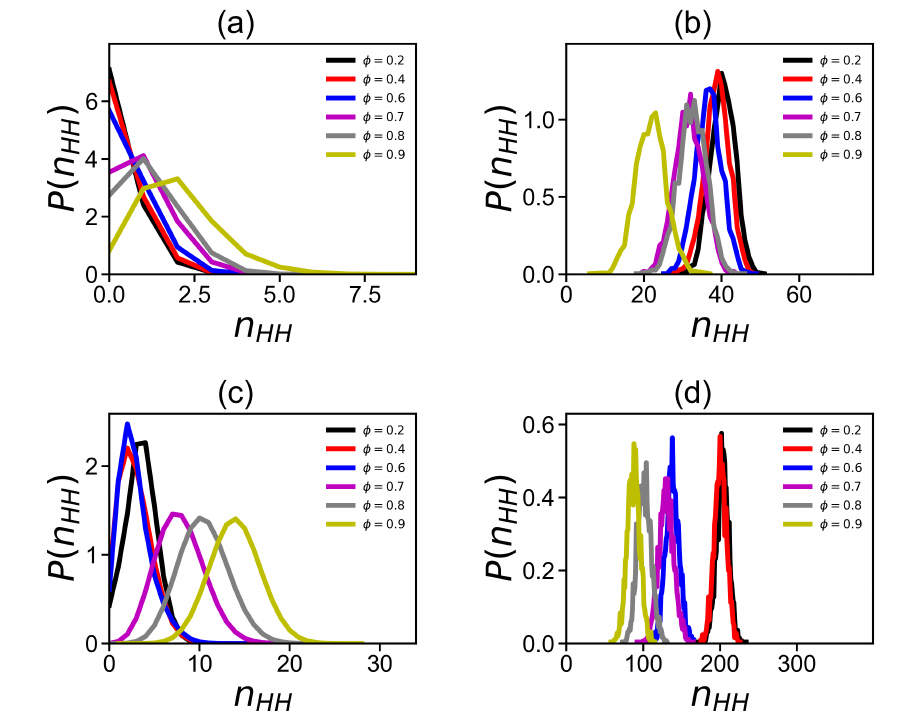
Figure 9. The distribution function of the number of ( a ) intra-dendrigraft hydrogen bonds and ( b ) hydrogen bonds between the dendrigraft and solvent at different methanol fractions φ for DGL1. The distribution function of the number of ( c ) intra-dendrigraft hydrogen bonds and ( d ) hydrogen bonds between the dendrigraft and solvent at different methanol fractions φ for